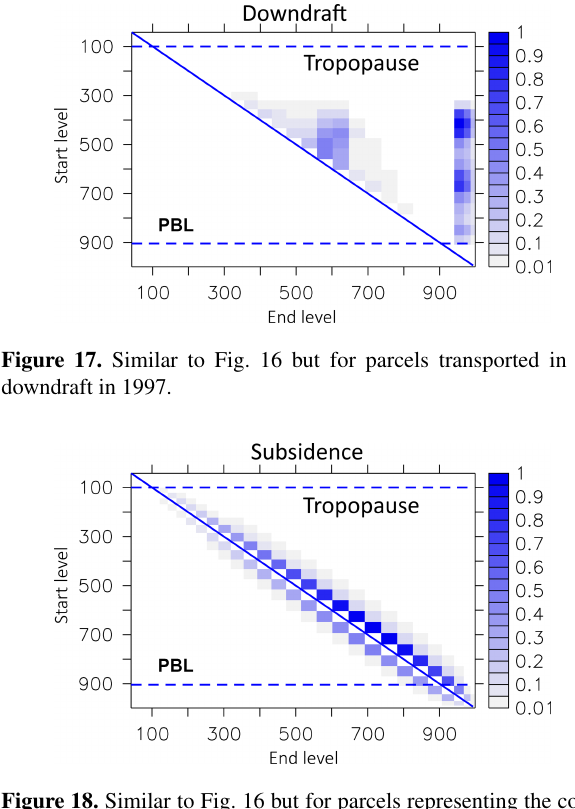
Figure 18. Similar to Fig. 16 but for parcels representing the com- pensating movement in the environment (subsidence) in 1997. Note that there is also a compensating upward parcel movement (shown below the blue diagonal line). For details, see the